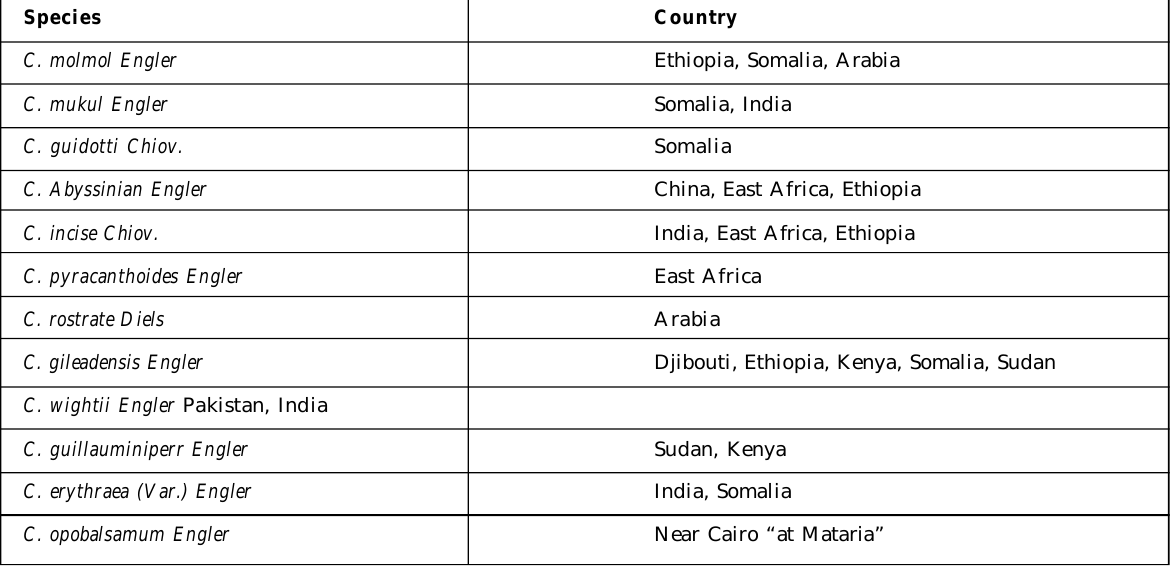
Figure 1 The plant commiphora myrrh. Figure 1 : The plant commiphora myrrh Table 1: The different species of plant Commiphora (El Ashry et al . , 2003)